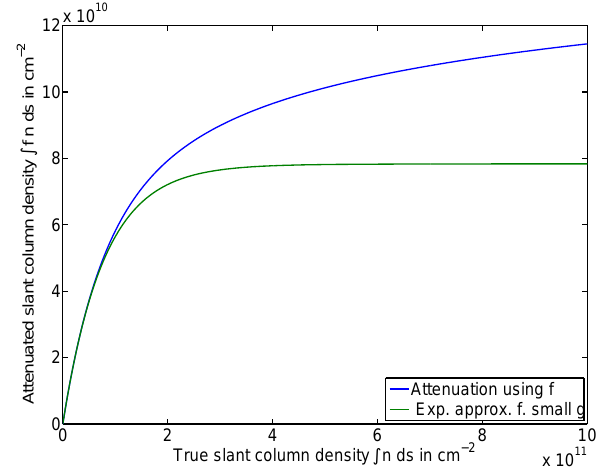
Fig. 19. Calculated attenuation f as a function of g for the Mg 285.2nm line. Taking isotopic shifts into account reduces the ab- sorption effect and f is higher for this case. The black lines show variations in the absorption behavior in the range of typical temper- atures in the 90km to 100km altitude range, resulting in a different Doppler broadening of the absorption cross section profiles.